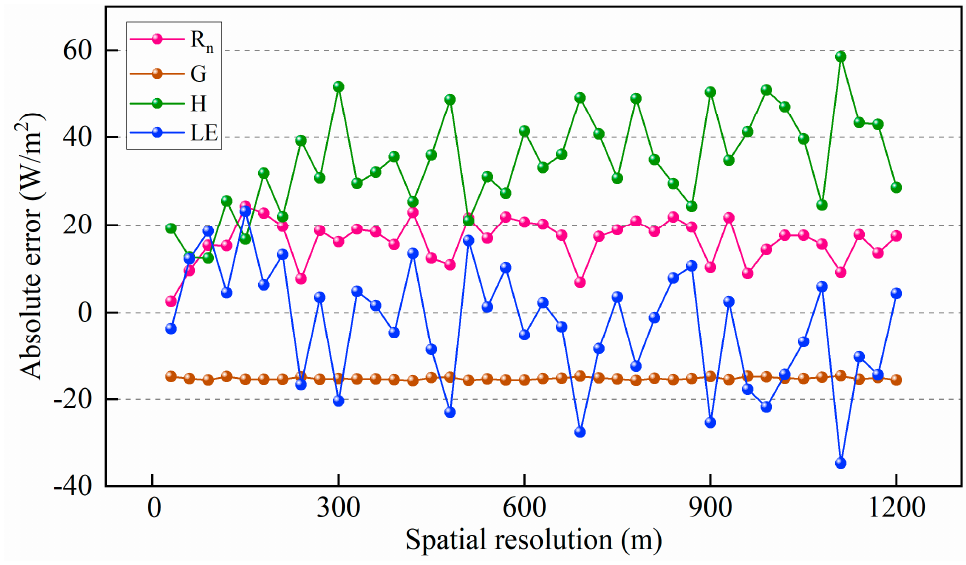
Figure 8. Absolute error variation between the eddy covariance observed fluxes and the SEBAL simulated fluxes at different spatial resolutions.